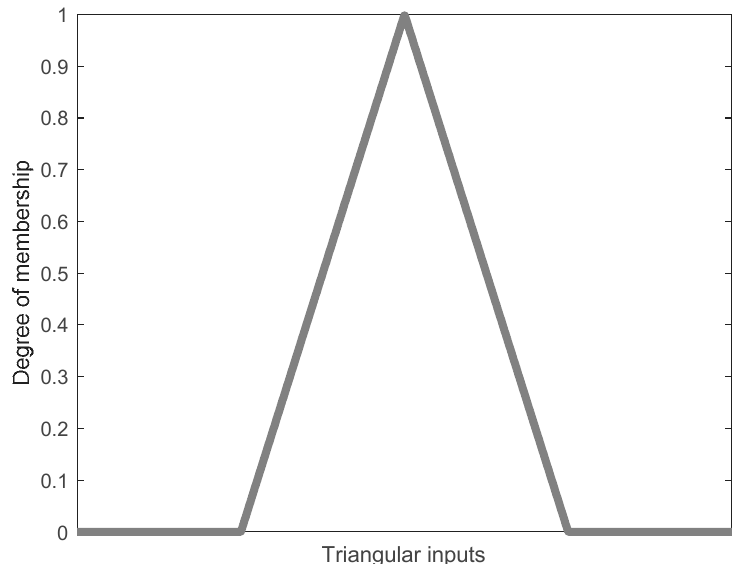
Triangular inputs Figure 1. Degree of membership of the independent Figure 1. Degree of membership of the independent variables.